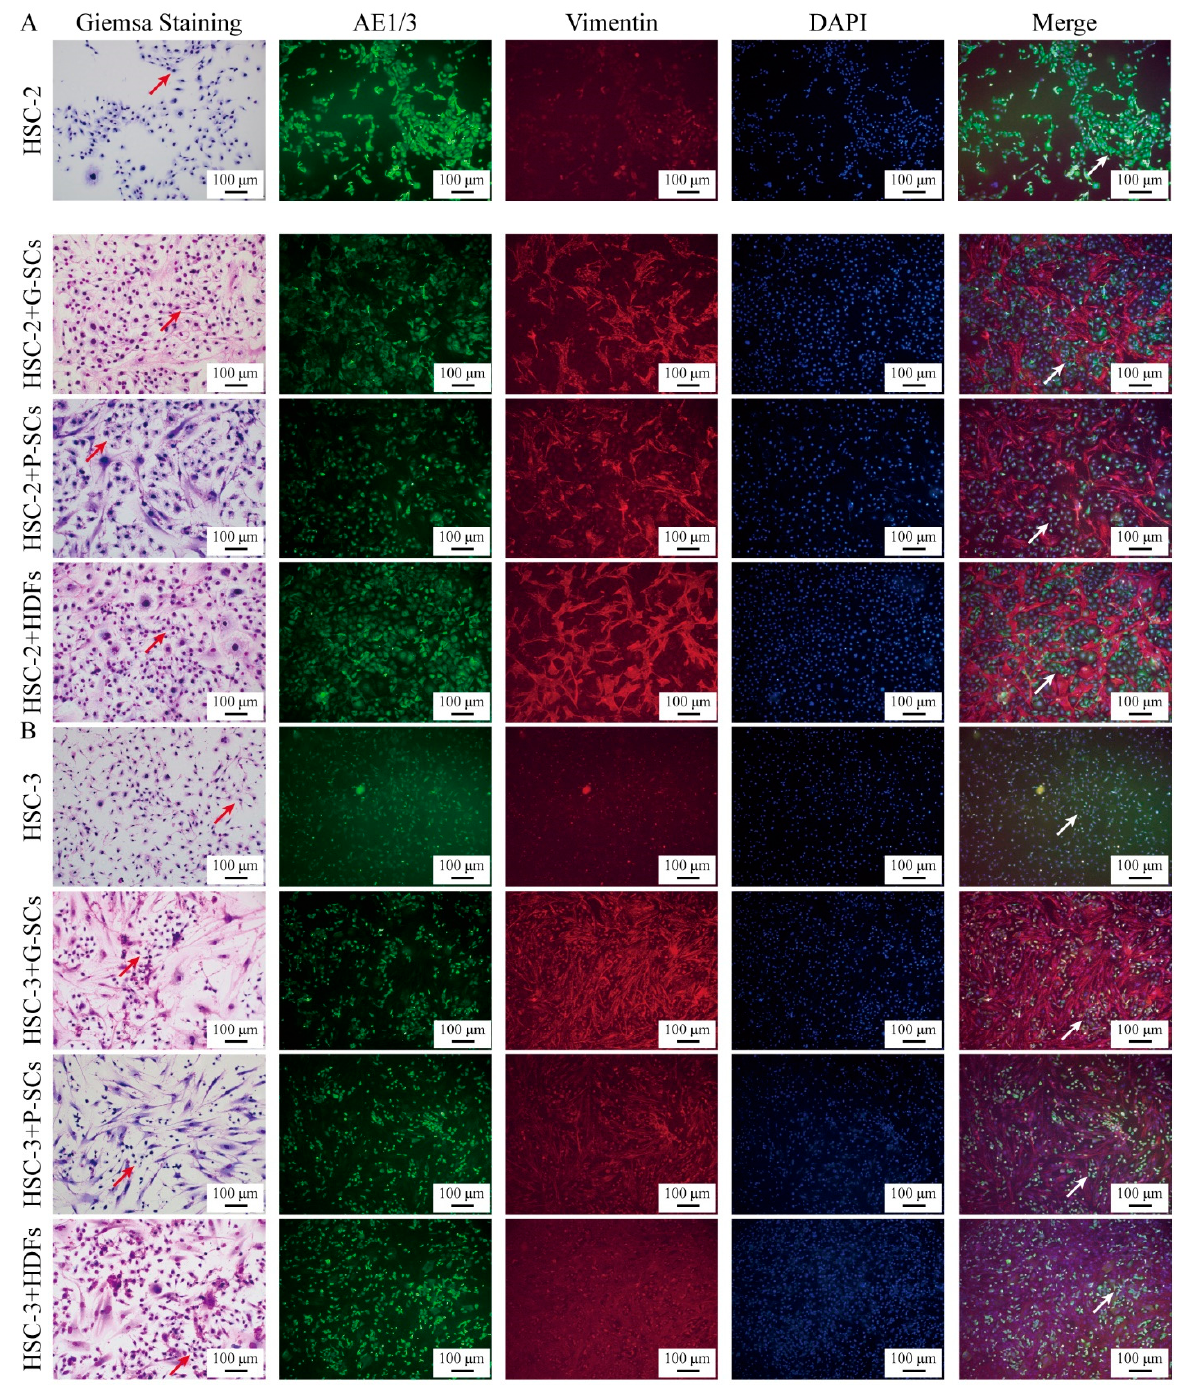
Figure 2. G-SCs and P-SCs inhibited the differentiation of OSCC cells in vitro. ( A ) The effect of G-SCs and P-SCs on the differentiation of HSC-2 was examined by both Giemsa staining and IF. ( B ) The effect of G-SCs and P-SCs on the differentiation of HSC-3 was examined by both Giemsa staining and IF.